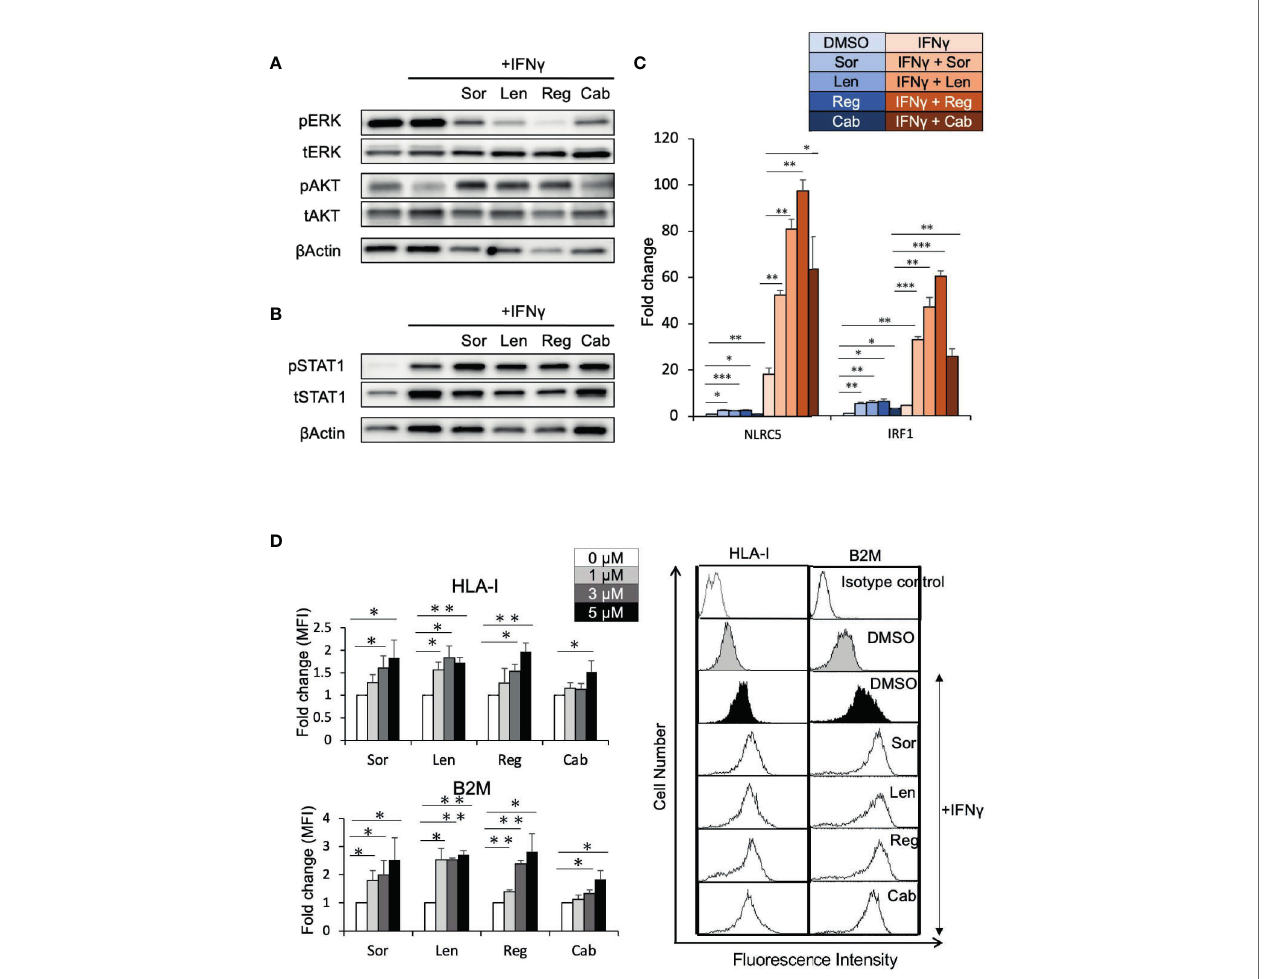
FIGURE 5 | Tyrosine kinase inhibitors induce HLA-I expression by augmenting the IFN g /STAT1 signaling pathway. (A, B) Huh7 cells were treated with each drug at 5 m M in the presence of IFN g (1 ng/mL) for 24 hours (A) or for 72 hours (B) . Immunoblotting analysis was performed to detect the protein levels of ERK, AKT, and STAT1. b -actin was used as a loading control. (C) Huh7 cells were treated with indicated inhibitors at 5 m M with or without IFN g over 48 hours. NLRC5 and IRF1 mRNA expression was analyzed using real-time PCR. Data are expressed as fold change relative to vehicle-treated cells. (D) Huh7 cells were treated with each drug at the indicated concentrations with IFN g . Cell surface HLA-I and B2M levels were measured 72 hours later by fl ow cytometry. The y-axis represents average MFI for 3 independent experiments, expressed as fold change relative to cells treated with IFN g alone. A representative fl ow cytometry histogram is shown. Sor, sorafenib; Len, lenvatinib; Reg, regorafenib; Cab, cabozantinib. (*: p < 0.05, **: p < 0.01, ***: p <